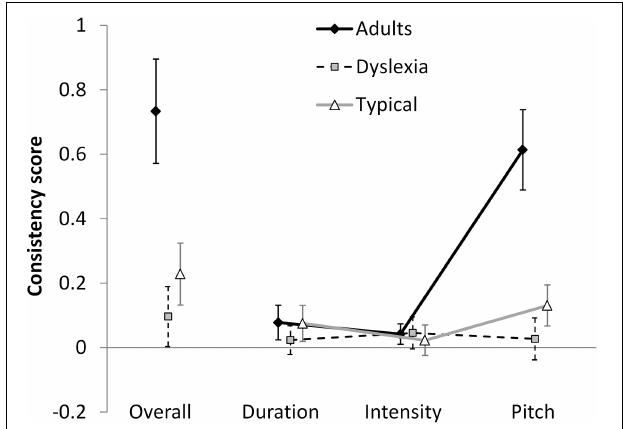
FIGURE 2 | Overall Consistency scores and specific Consistency scores (for Duration, Intensity, and Pitch) of Adults, Typical Developing children and Dyslexic children. Each Overall score is the sum of the three specific scores. The Consistency scale (vertical axis) extends from –0.5 (perfect in-consistency) to 0 (chance level) to 1 (perfect consistency). Error bars report 95% confidence